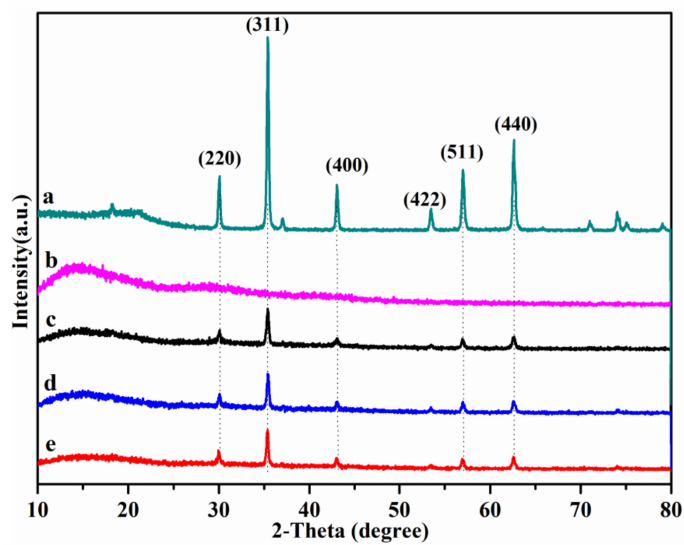
Figure 2. XRD patterns of ( a ) Fe 3 O 4 nanoparticles; ( b ) PMMA; ( c ) magnetic PMMA; ( d ) magnetic PMMA-PGMA and ( e ) magnetic